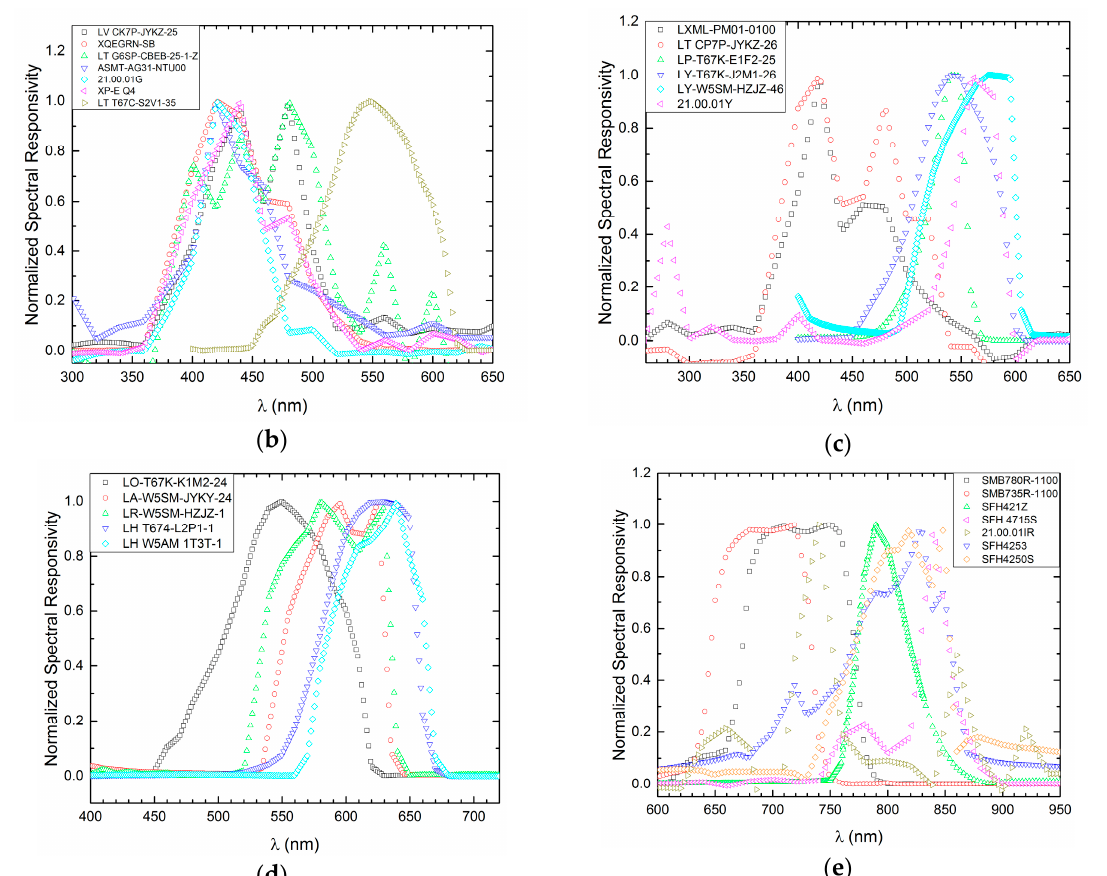
Figure 4. Normalized spectral detection of LED detectors in the peak wavelength range from: ( a ) 350 nm to 450 nm; ( b ) 400 nm to 600 nm (first group); ( c ) 400 nm to 600 nm (second group); ( d ) 550 nm to 650 nm; and ( e ) 650 nm to 850 nm.